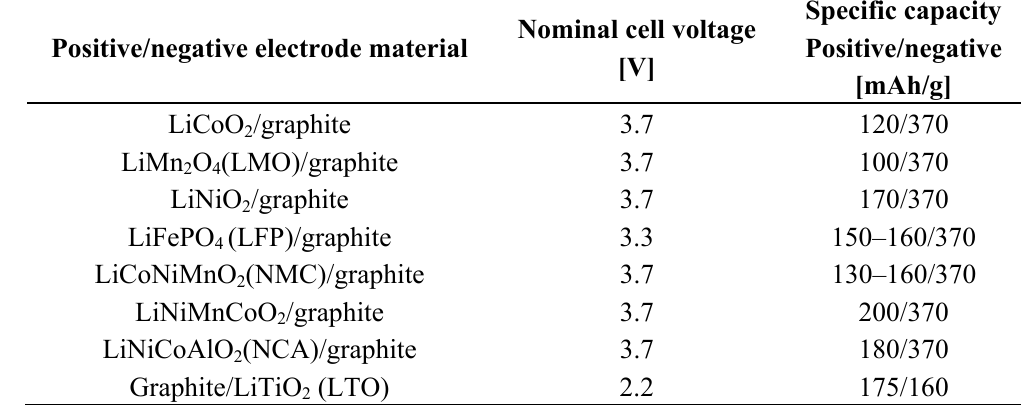
Table 2. Comparison of the most relevant anode and cathode materials